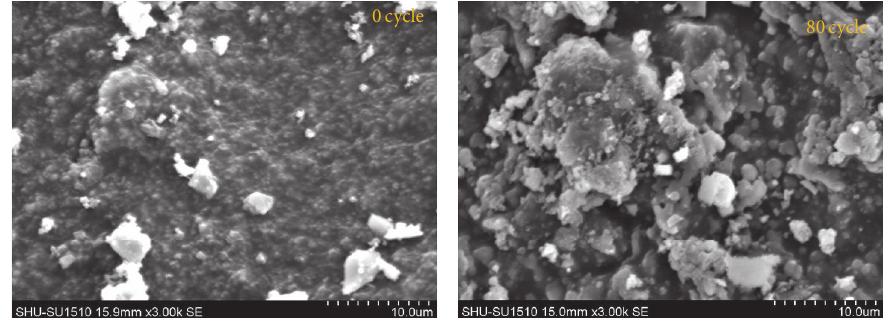
Figure 12: SEM graphs of top finish on the finishing coat.